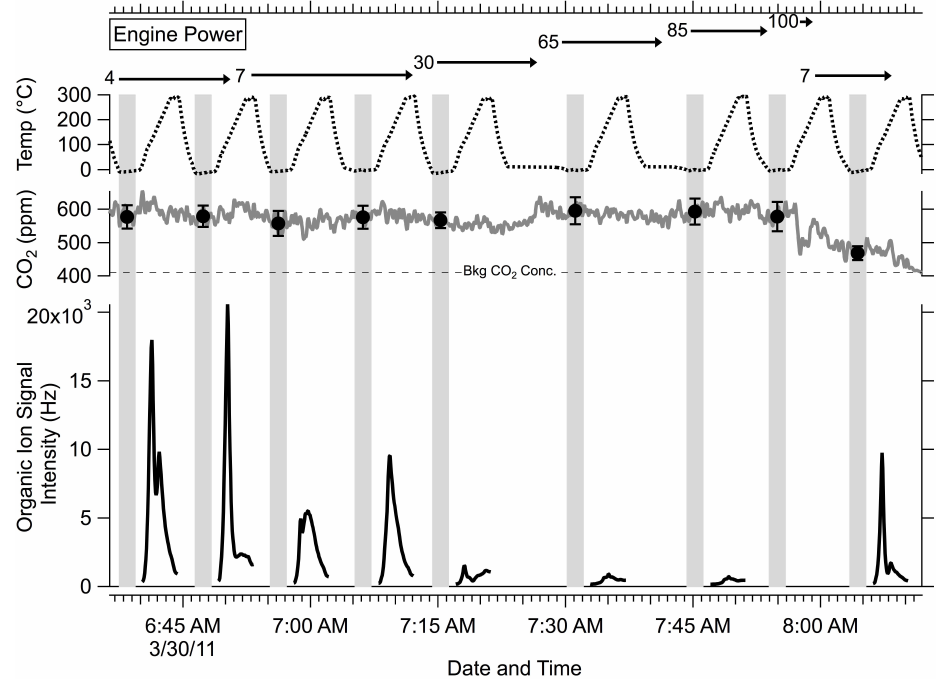
Fig. 4. Timeline showing the sample collection/desorption cycles during the 30 March 2011 power sweep: jet engine power setting, measured CO 2 level at 143m, collection temperature, collection period and total organic ion signal. Elevated CO 2 levels recorded at the 143m inlet position are shown in the middle panel, with the dashed line demarcating the ambient CO 2 background